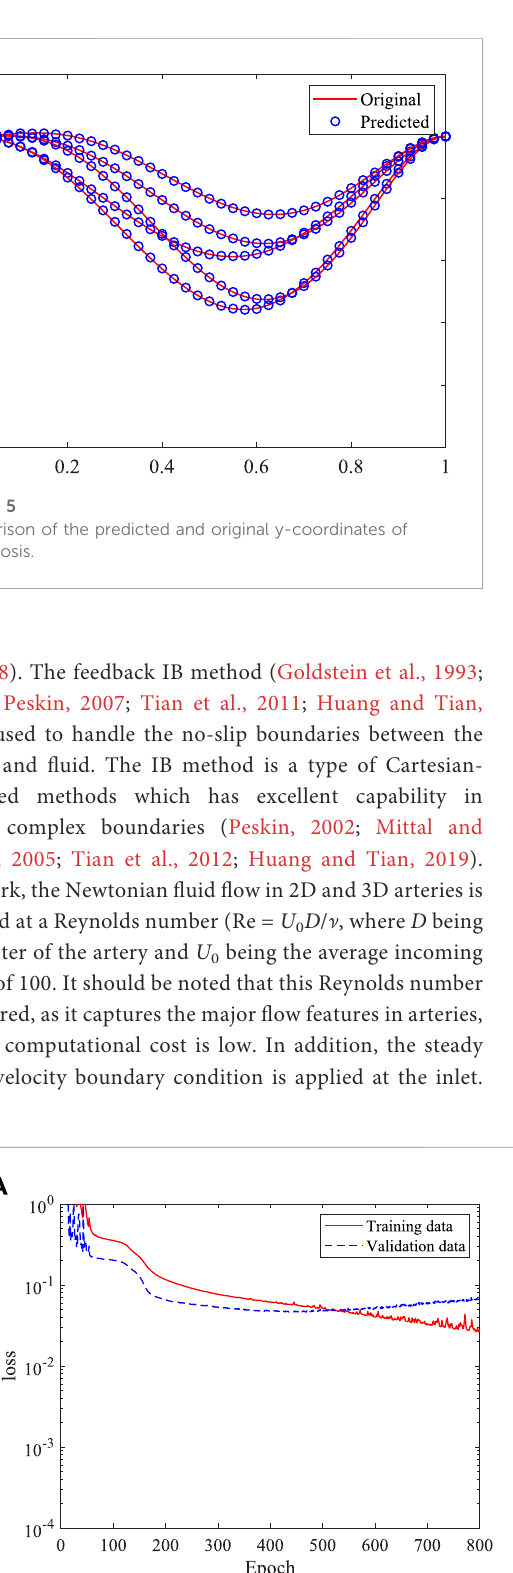
FIGURE 6 Time histories of loss of the DNN in a 2D channel with a stenosis: (A) polynomial factors, and (B) CNN-extracted characteristic parameters.